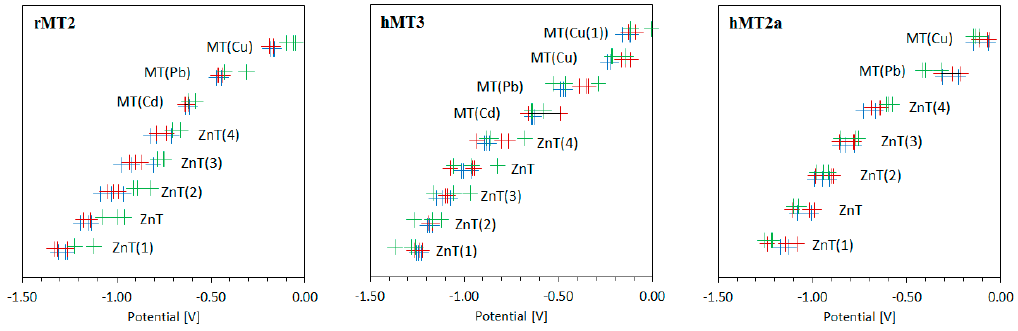
Figure 5. Deconvoluted peak potential for rMT2, hMT3, and hMT2a for accumulation (+++), concentration (+++), and pH (+++).